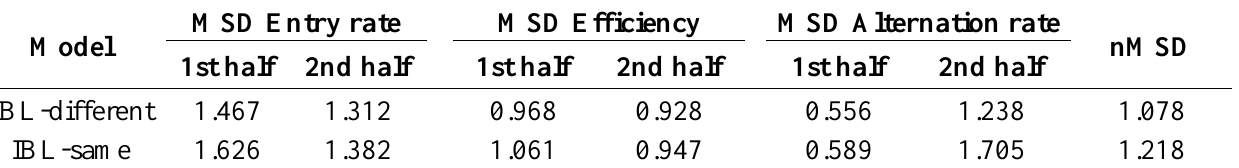
Table 2. Summary of results in the Competition